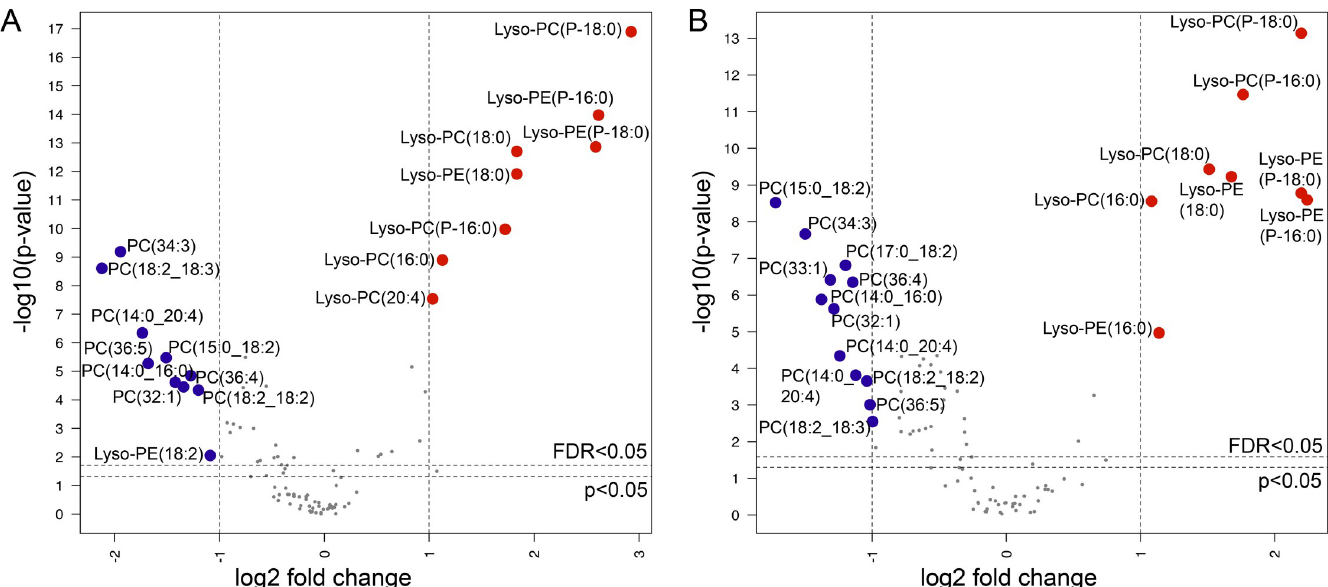
Fig 4. Increased phospholipase activity in MDR-TB. Volcano plots of plasma lipids with confirmed chemical identities shows significant increases of lyso- phospholipids and significant decreases in phospholipids with two acyl chains in persons with MDR-TB with (n = 29) and without (n = 21) HIV co-infection versus (A) persons with latent TB infection (n = 20) and (B) persons with drug susceptible (DS)-TB (n = 30). The x-axis shows the log2 fold change in expression in MDR-TB versus controls and DS-TB for each lipid and the y-axis shows the -log p-value for each comparison after adjustment for age, sex and HIV status. Lipids upregulated in MDR-TB with > 1 log2 fold change at a false discovery rate (FDR) [60] of q < 0.05 are labelled in red and those downregulated are labelled in blue.